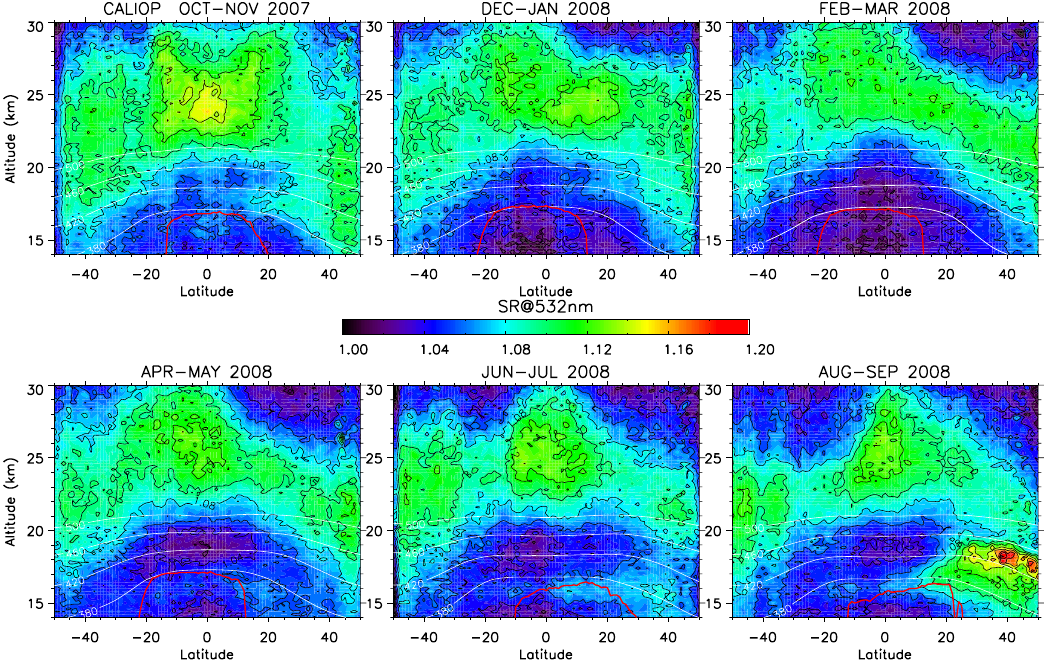
Fig. 4. Latitude-height cross-sections of mean CALIOP SR from September 2007 to August 2008 every two months. Shown by white lines are temperature potential levels at 380, 420, 460 and 500K and by red lines the mean cloud top height (zonal mean depolarization ratio =